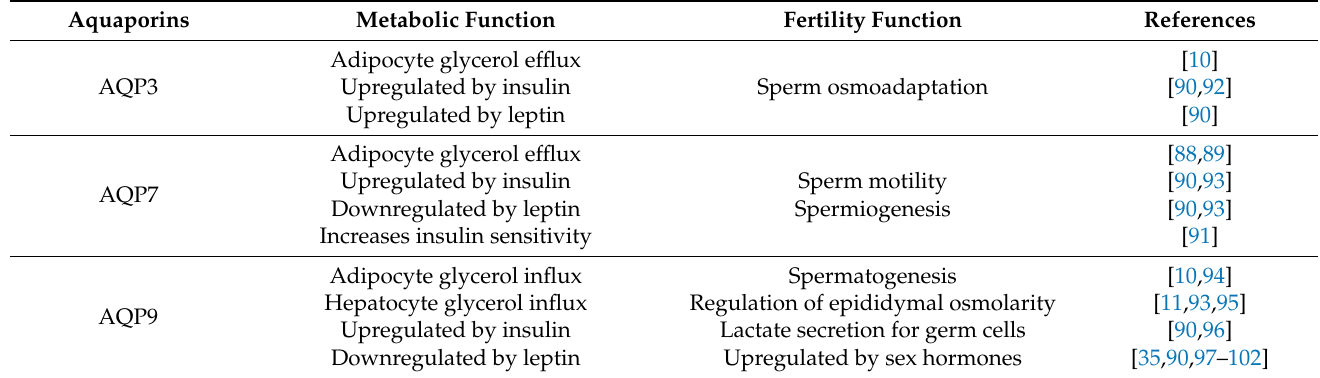
Table 1. Aquaporin (AQP)-3, 7, and 9 functions on metabolism and in male fertility. Aquaporins Metabolic Function Fertility